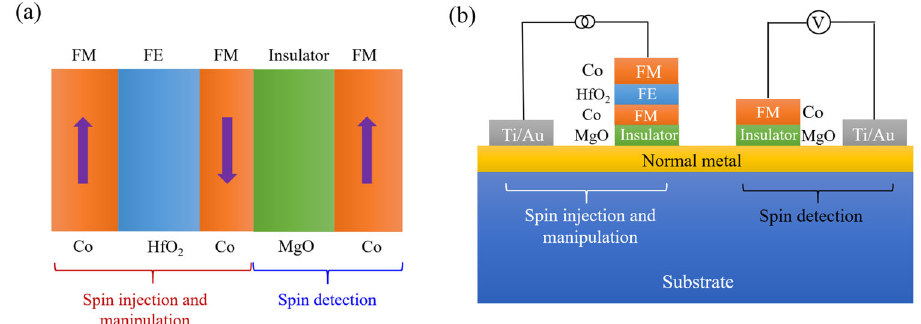
Fig. 6 Schematic device structures for detecting the spin current generated by the proposed MFTJs. a Ferroelectric switching MTJs (FE- MTJs): the left three layers constitute an MFTJ for spin generation and manipulation; the right two layers are for spin detection. The whole device is at a low-resistance/high-resistance state when the injected current is parallel/antiparallel with the far-right ferromagnetic layer. b Nonlocal spin valve for spin detection. Spin current is injected from the left two electrodes and is detected by the right two electrodes. The spin polarization direction of the injected current is switched with the reversal of ferroelectric polarization without a magnetic fi